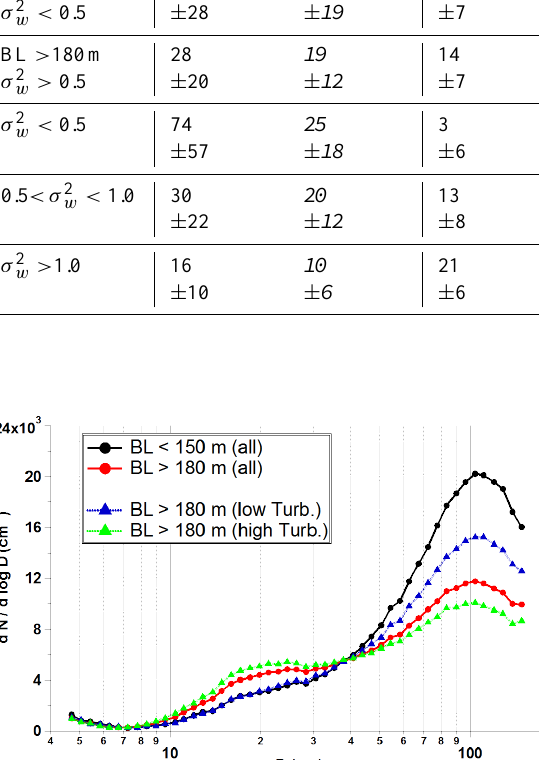
Fig. 7. Average nano-SMPS size distributions at the BT Tower site for periods of: UBL height below the BT Tower sampling height ( < 150m); high UBL height ( > 180m); low σ 2 w ( < 0.5m 2 s − 2 ) and high σ 2 w ( > 0.5m 2 s − 2 ) . Measurements of UBL height and σ 2 w were derived from the Lidar, using z MH as the measure of UBL